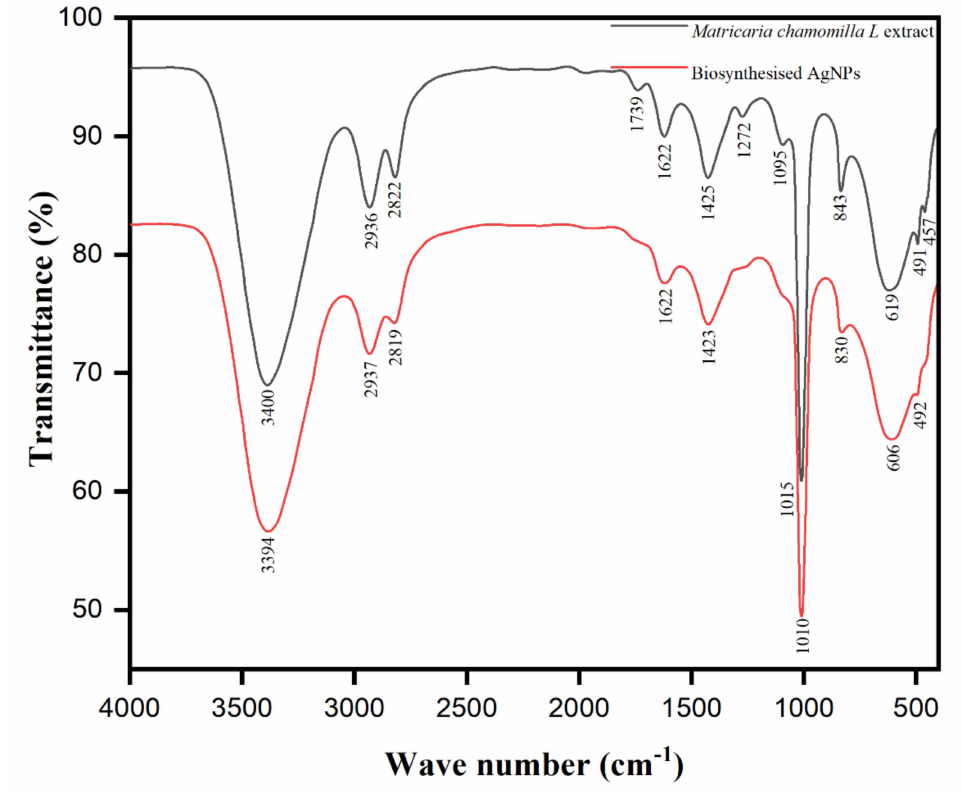
Figure 7. FTIR spectra of the Matricaria chamomilla L. extract and biomolecule-capped